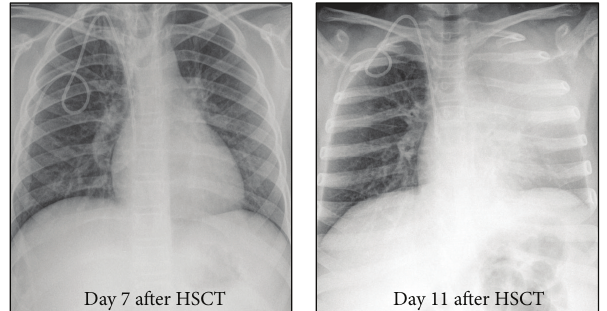
Figure 3: Chest X-rays performed on days 7 and 11 following transplant. No lung abnormality is seen at day 7 but left upper lobe collapse has developed by day 11 after